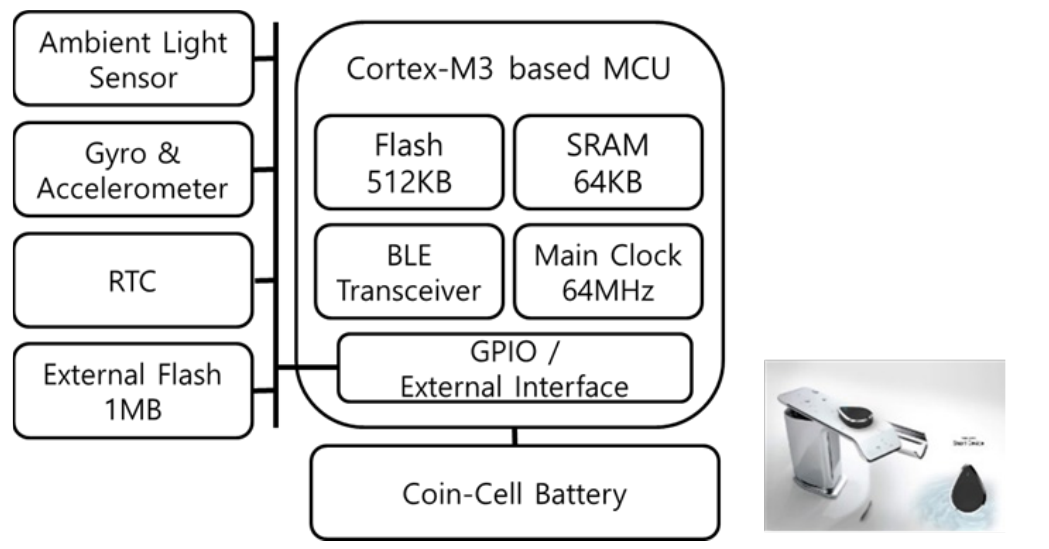
Figure 16. Hardware Block Diagram of External Sensor Device.